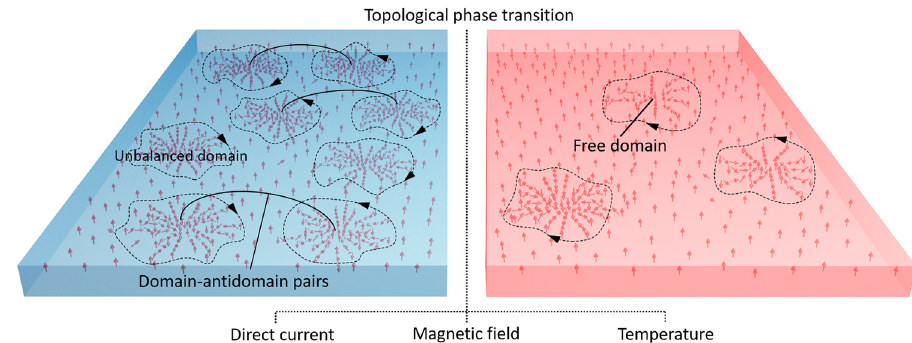
Fig. 1 Schematics of the BKT-like transition driven by the binding and unbinding of domain-antidomain pairs in a QAHI fi lm. In the BKT-like phase (blue panel), domains pair up (black arcs) with antidomains but these pairs dissociate (red panel) when getting out of the this phase by controlling parameters like the applied direct current, magnetic fi eld, and temperature. The broken time-reversal symmetry results in chiral and antichiral edge states around the boundaries of domains and antidomains (clockwise and counterclockwise dashed circular arrows). Different from the standard 2D-XY model, there may be some unbalanced domains besides the pairs in the